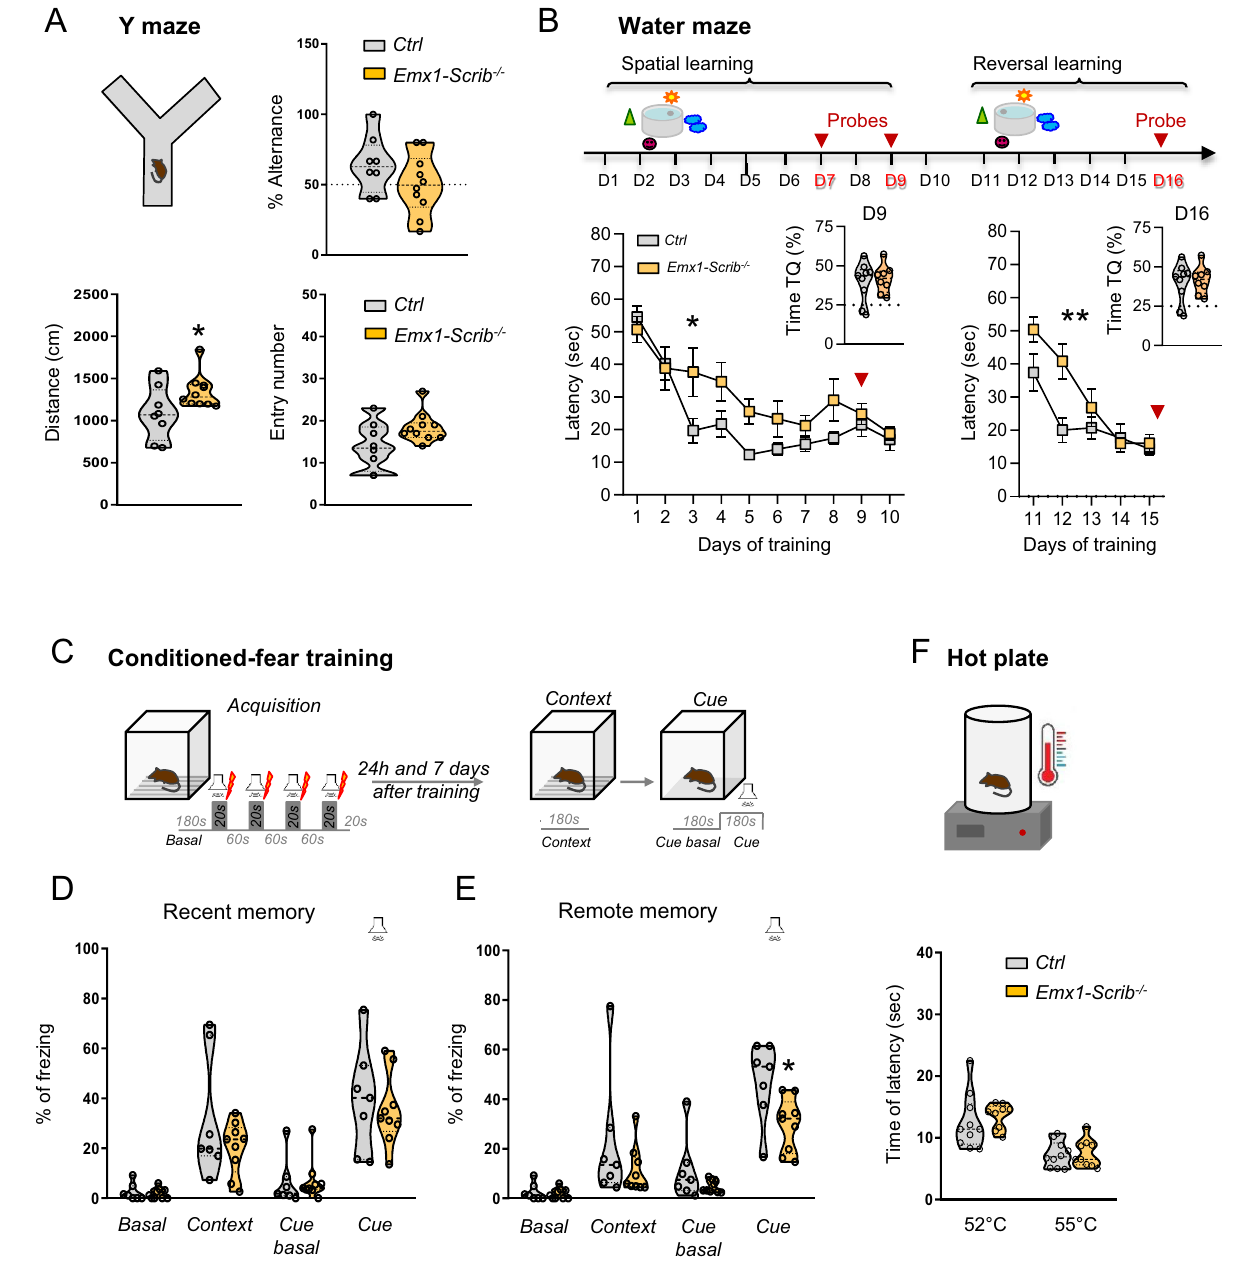
Figure 8. Spatial learning and long term memory deficit in Emx1-Scrib −/− mice. ( A ) Upper panel, Y maze test apparatus and alternance rate percentage in the Y maze test. Lower panel, total distance travelled and total number of entries in the Y maze test (control: n = 8 mice; Emx1-Scrib −/− : n = 10 mice). ( B ) Upper panel, design of the Morris water maze apparatus task. Lower panel, the learning curve showing escape latency during the spatial and reversal training sessions. Time spent in target quadrant during the probe test at day 9 and day 16 are represented in the right corner of each graph (control: n = 9 mice; Emx1-Scrib −/− : n = 8 mice). ( C ) Upper panel, design of the fear conditioning apparatus task. ( D,E ) Freezing levels in context and tone fear conditioning. ( D ) Percentage of freezing measured before training (basal), 24 h (recent memory) after training. ( E ) Percentage of Freezing measured before training (basal) and 7 days (remote memory) after training (control: n = 7 mice; Emx1-Scrib −/− : n = 9 mice). ( F ) Lower, Hot plate apparatus. Time spent to paw withdrawal in the hot plate test at 52 °C and 55 °C (control: n = 10 mice; Emx1-Scrib −/− : n = 9 mice). Data were represented either as violin plots with single data point as a dot or as mean ±